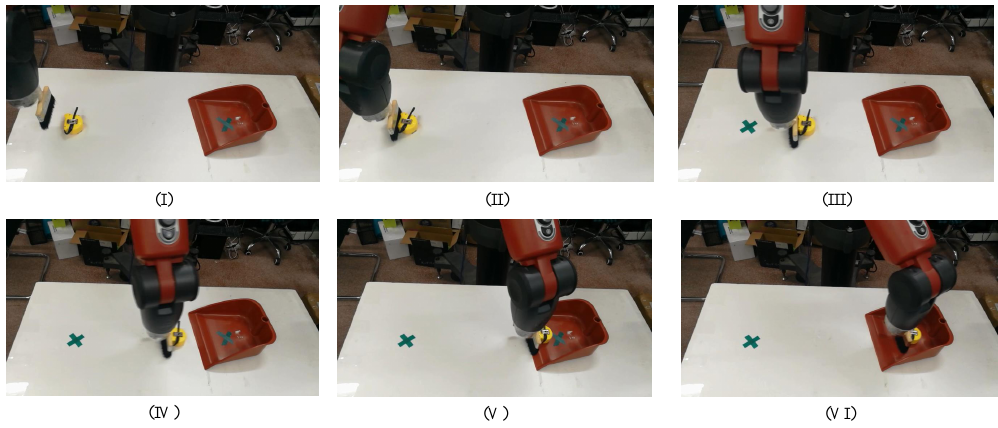
Figure 10. Robot execution by employing the LWR algorithm.